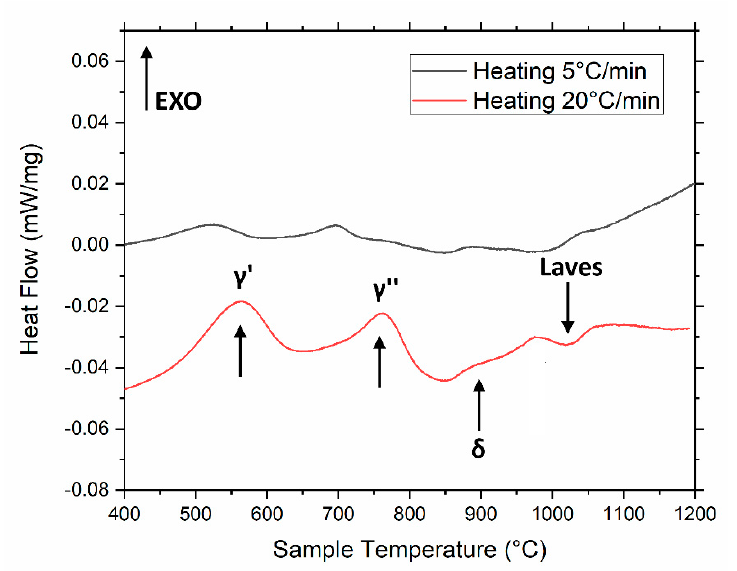
Figure 1. Differential scanning calorimetry (DSC) of as-built Inconel 718 at different heating rates. The arrows indicate the peaks detected, as also found in [13,32].